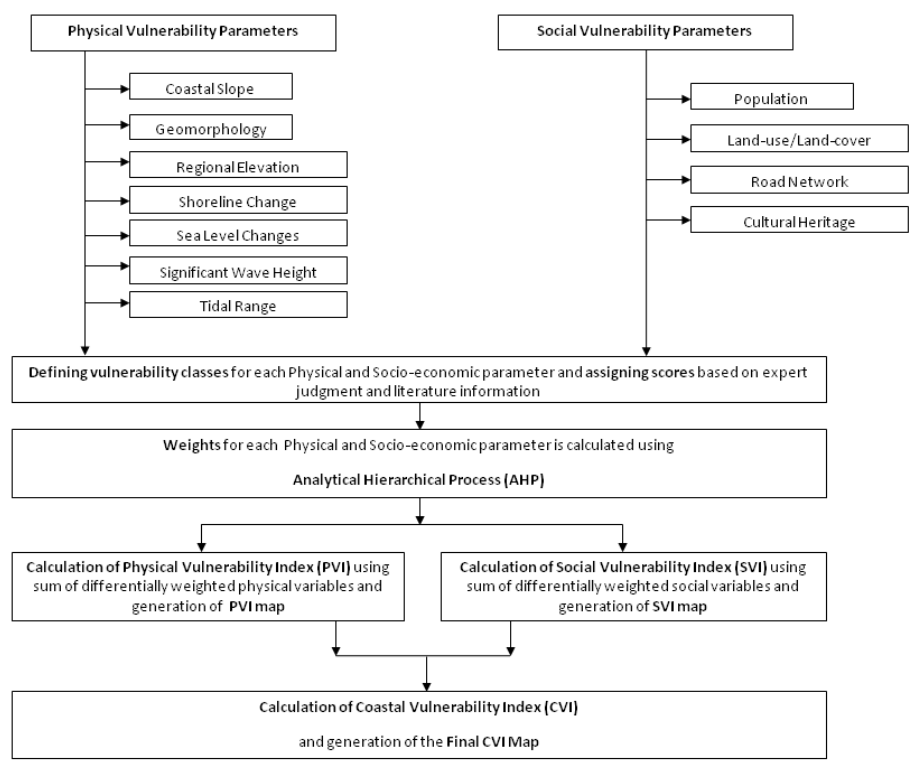
Fig. 2. Flow diagram summarizing the methodology adopted in this study for the calculation of Coastal Vulnerability Index (CVI) and generation of the CVI